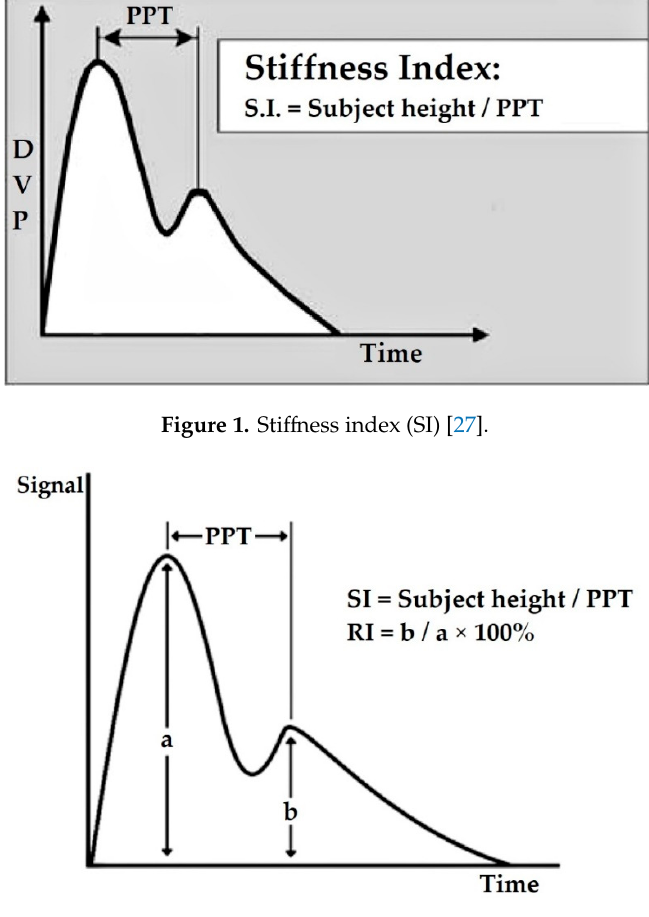
Figure 2. Reflection index (RI) [30].